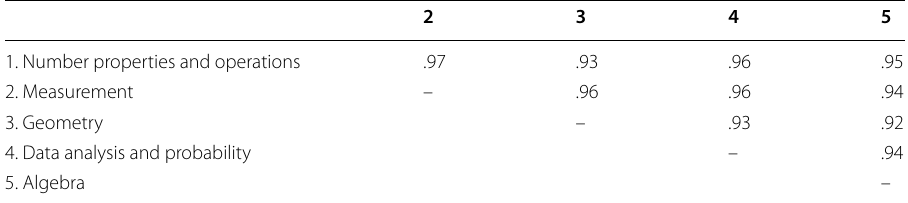
Table 5 Correlations between dimensions in five-dimensional 3PL/GPCM for math grade 8 data